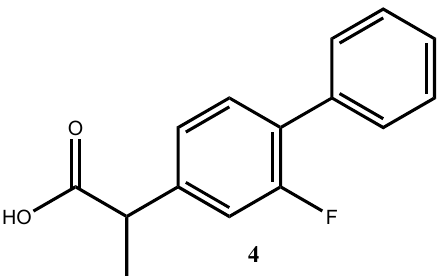
Figure 3. Structural formula of flurbiprofen.